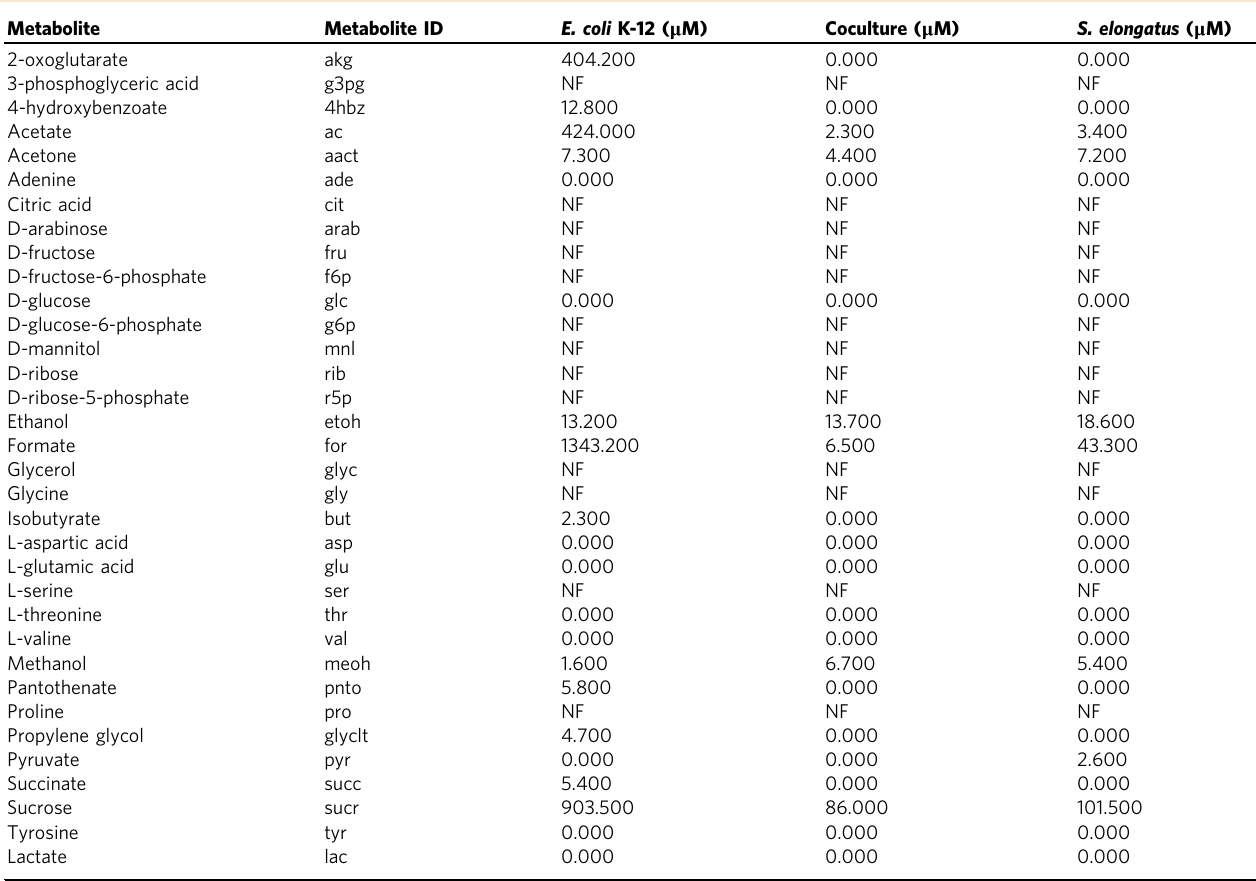
Table 2 NMR data for extracellular metabolite